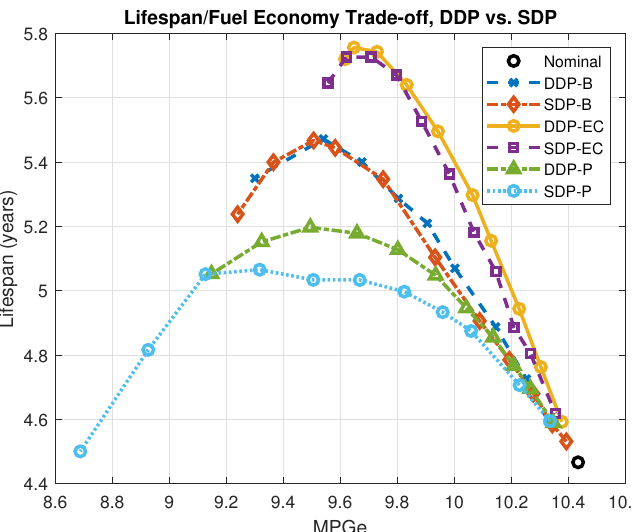
Figure 6. Energy consumption and battery aging for the DP-based methods for N pc = 100.